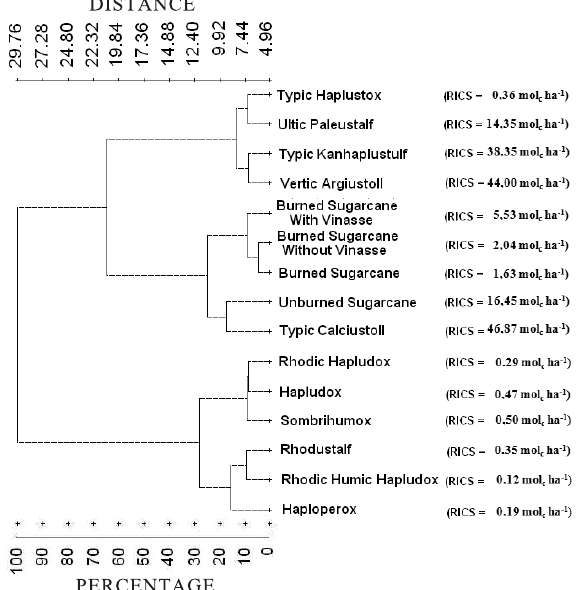
Figure 1. Dendrogram for the minimum variance based on Euclidean distances obtained by multivariate analysis of all variables for the group of studied samples and Redox Index of Carbon Stability